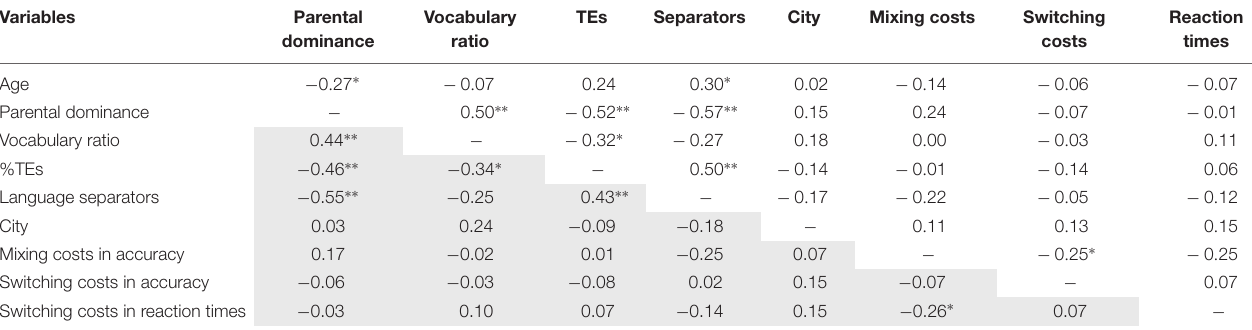
TABLE 2 | Scores on the advanced dimensional change card sort task by parental reports of dominance group.